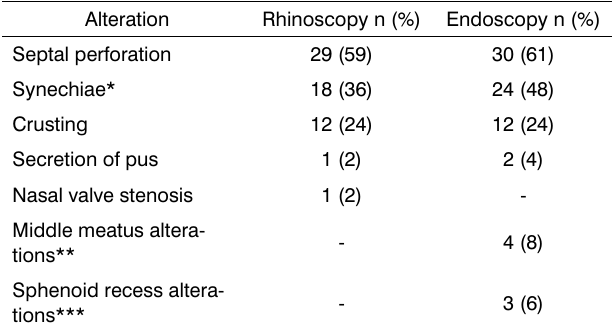
Table 2. Frequency of complaints and alterations in the otorhinola- ryngological exam in patients undergoing transsphenoidal surgery for the treatment of pituitary adenoma